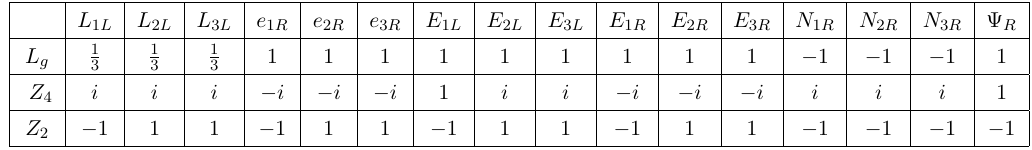
Table 2 . Lepton assignments under Z 4 (cid:2) Z 2 and the values of generalized Lepton Number L g . To implement the radiative seesaw mechanisms that generate the observed hierarchy of the SM charged fermion masses and mixing angles by a sequential loop suppression and the light active neutrino masses from a combination of linear and inverse seesaw mechanisms at two loop level, we extend both the fermion and the scalar sectors of the 3-3-1 models 1 p with (cid:12) = previously considered in the literature. We introduce SU(3) L singlet exotic 3 (cid:0) up type